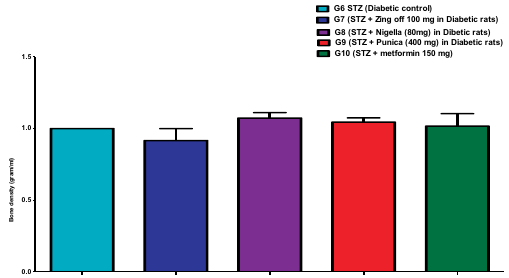
.Fig. 5. Comparison of the bone density (gram/ml) in different studied groups.